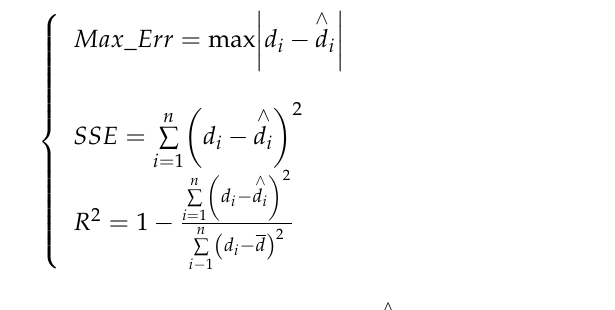
Figure 7. Fitting result using thin-plate spline interpolation method. Figure 8. Fitting result using Green’s function-based interpolation method.